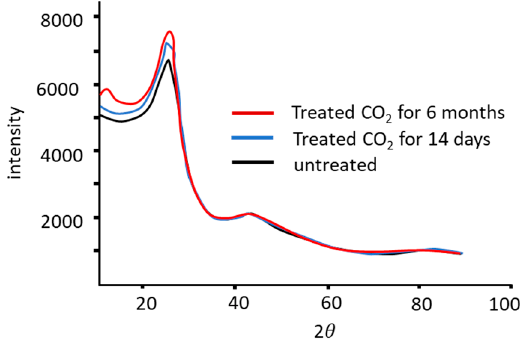
Figure 8. The XRD pattern obtained from untreated coal and coal treated CO 2 for different time spans. The primary difference is at 2 𝜃 = 23 ° . Modified from [128].